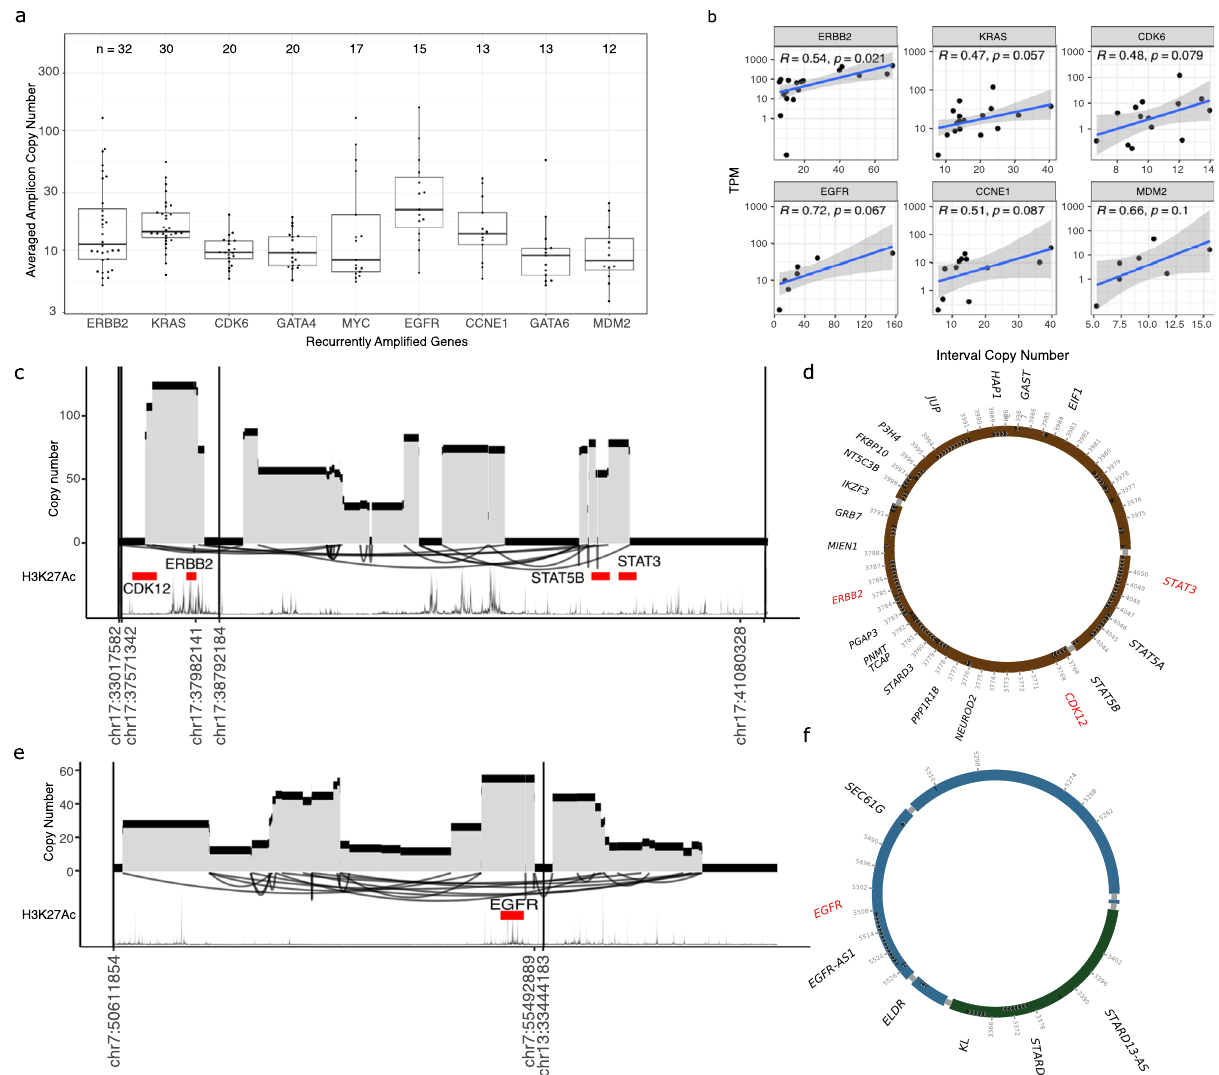
Fig. 2 Complex SVs leading to ampli fi cation of oncogenes. a Recurrent amplicons detected by Amplicon Architect associated with known OAC oncogenes. The number of tumours with detected amplicon is shown above. Y -axis showing copy number of segments spanning each gene, averaged along the length of segment. b Correlation of gene expression (TPM) and copy number of amplicons. c Example of an ampli fi ed region spanning CDK12, ERBB2, STAT3 and STAT5B, resembling ecDNA and d Reconstructed amplicon as an extrachromosomal circle containing ERBB2 and a CDK12-STAT5B fusion. e An ampli fi ed region spanning EGFR and joining chromosomes 7 and 13, forming an ecDNA and reconstructed as a circle ( f